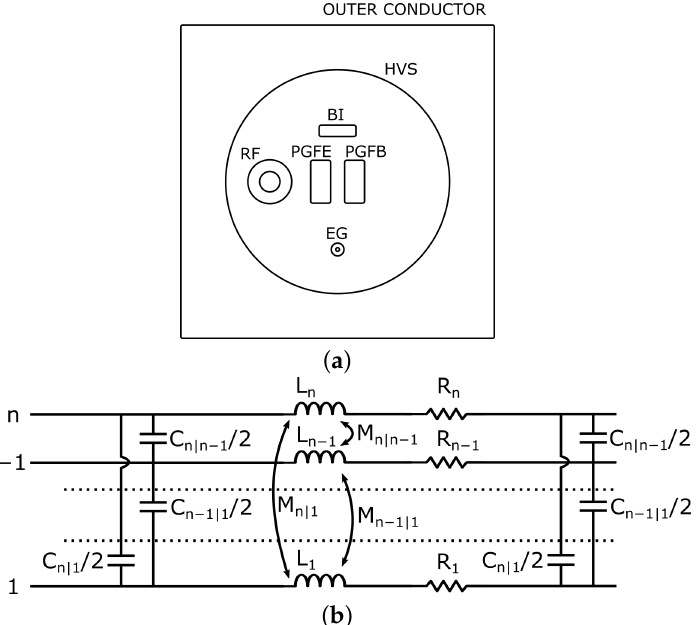
Figure 3. SPIDER transmission line considered in the circuital model. ( a ) SPIDER TL cross-section (not in scale). ( b ) Equivalent pi-representation of the multiconductor